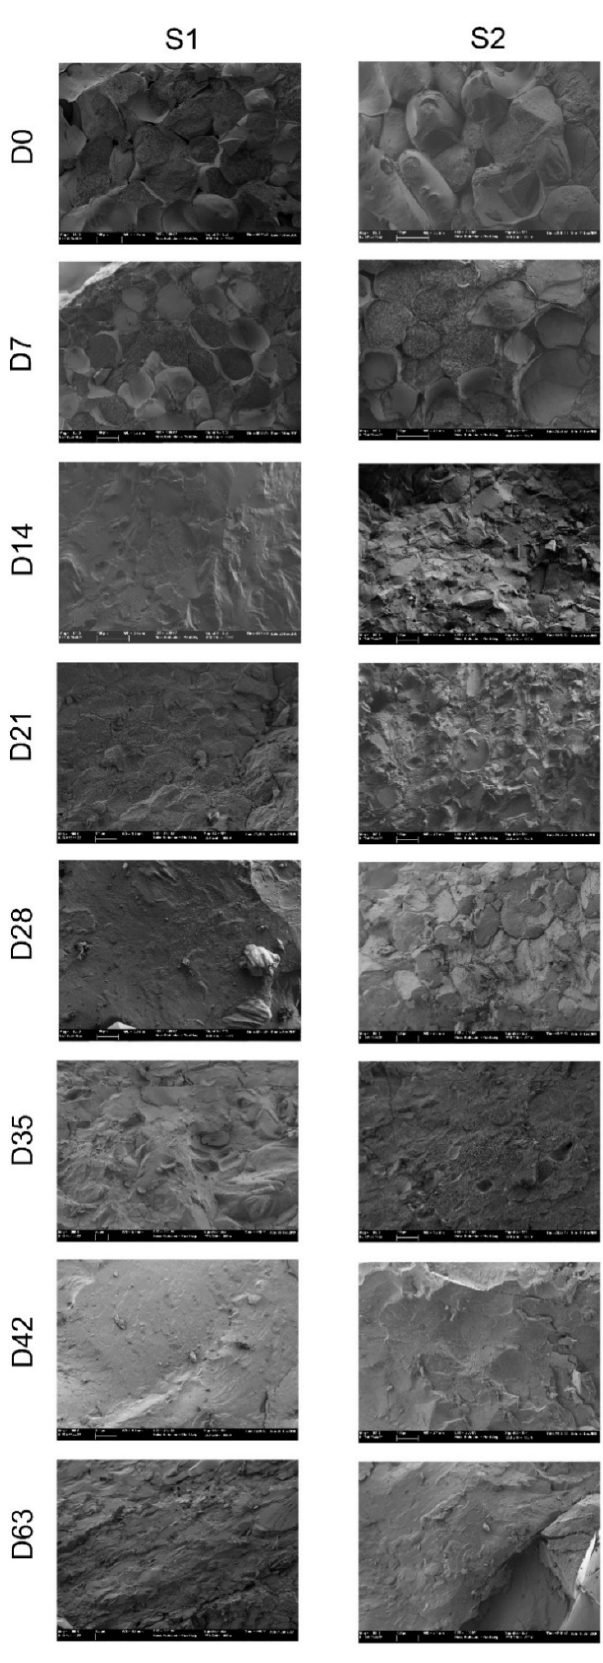
Figure 6. Internal flesh structure by the Cryo-field emission scanning electron microscopy technique of persimmon cv. Rojo Brillante in two maturity stages (S1 and S2) submitted to drying up to 63 days (D).